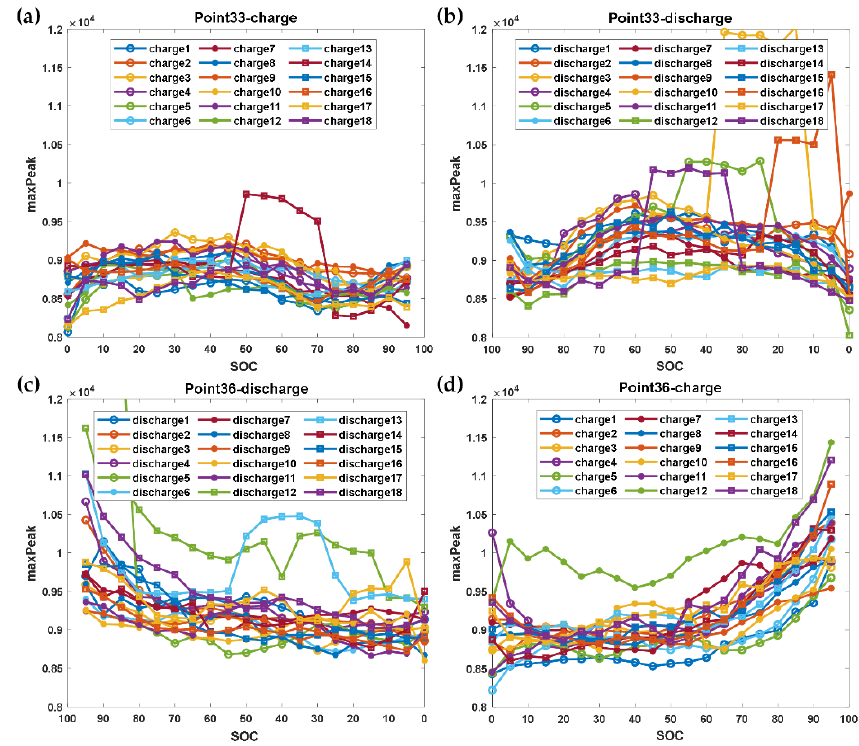
Figure 6. Variation of time domain peak values of UGW signal at a single-point with the change of battery SOC. (( a , b ) are the time-domain peak values of charge and discharge process at the 33rd scan point on the scan line, respectively; ( c , d ) are the time-domain peak values of charge and discharge process at the 36th scan point on the scan line, respectively.). Table 5. “Line” characteristic parameters used to characterize battery SOC.